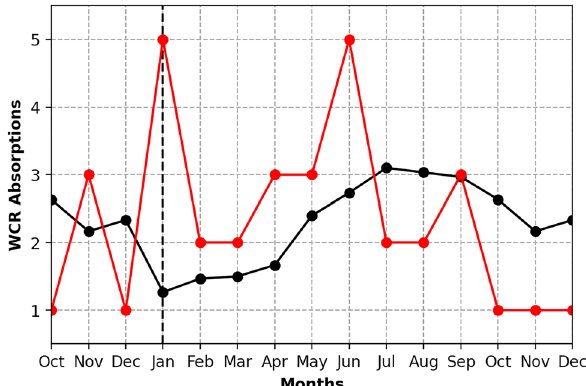
Figure 5. The number of WCR absorptions in the NWA from October 2015 to December 2016 (red line) is plotted against the absorption climatology for 1986–2016 (black line). An “absorption” occurs when a WCR merges back into the Gulf Stream or dissipates